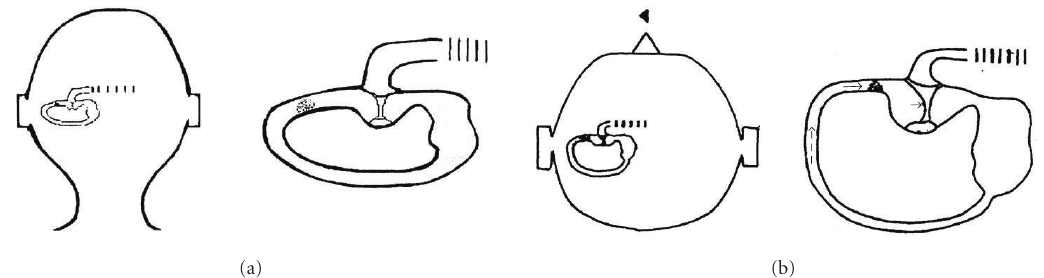
Figure 1: (a) Patient with a left LSC-BPPV of the apogeotropic form in sitting position (backward view): the debris is localized in the anterior arm of the canal and is free floating. (b) When the patient moves from the sitting to the supine position, the endolymphatic flow (dashed arrow) causes the debris to move towards the ampulla (thin arrow). Here, acting as a plunger, debris determines an ampullopetal deflection of the cupula (thick arrow), thus triggering a left-beating nystagmus (head arrow).